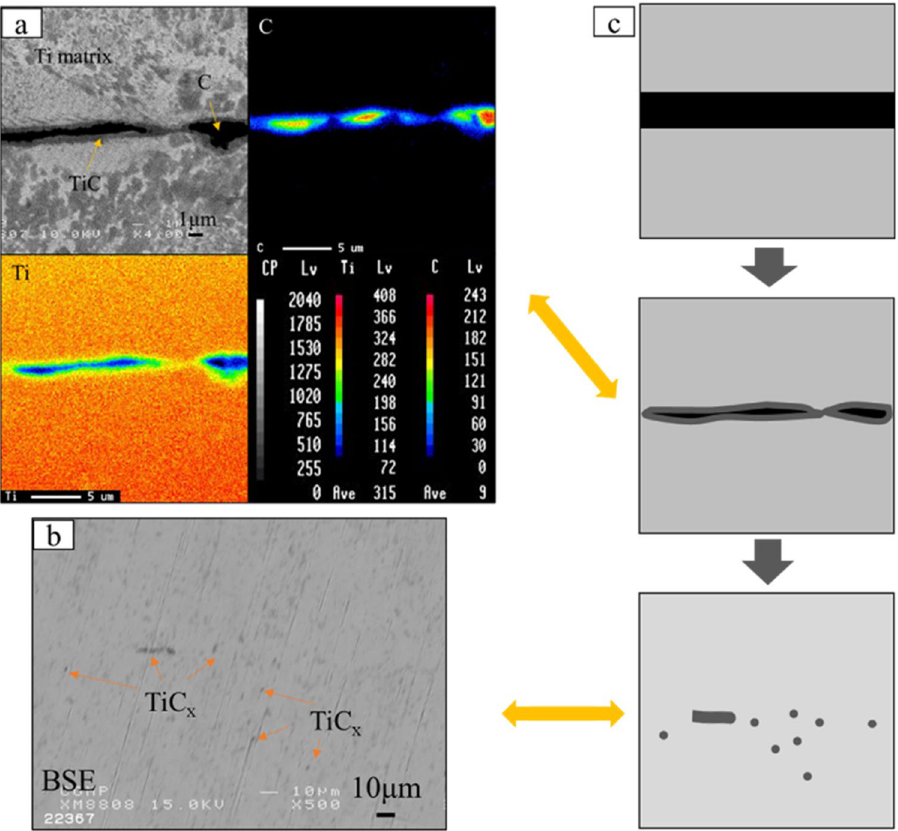
Figure 4. ( a ) BSE image and area mapping by EPMA of bonding area of TMC of 1073 K; ( b ) BSE image of TMC of 1273 K; ( c ) Schematic illustration of synthetic process of in-situ TiC particles dispersed TMC.